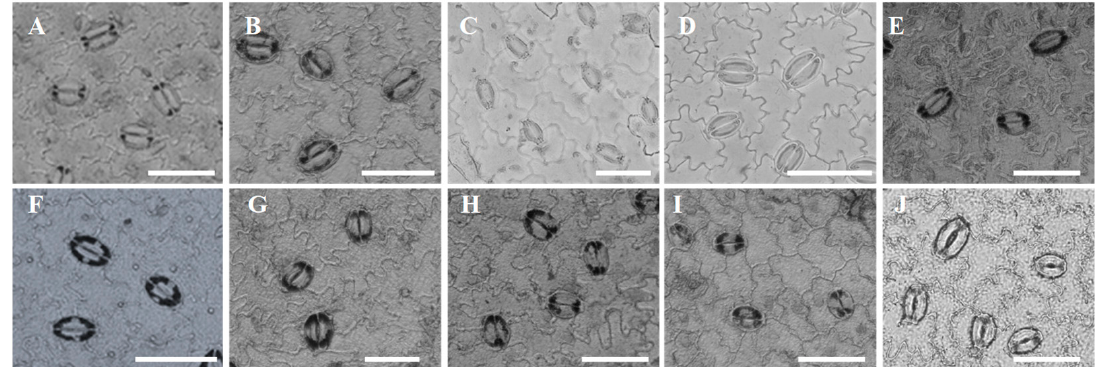
Figure 3. Characteristics of epidermal cells under light microscope in ten wild tree peonies, all abaxial. ( A ) P. qiui ; ( B ) P. decomposita ; ( C ) P. jishanensis ; ( D ) P. ostii ; ( E ) P. delavayi ; ( F ) P. lutea ; ( G ) P. potanini ; ( H ) P. rockii ; ( I ) P. ludlowii ; ( J ) P. cathayana . (bar = 50 μ m).